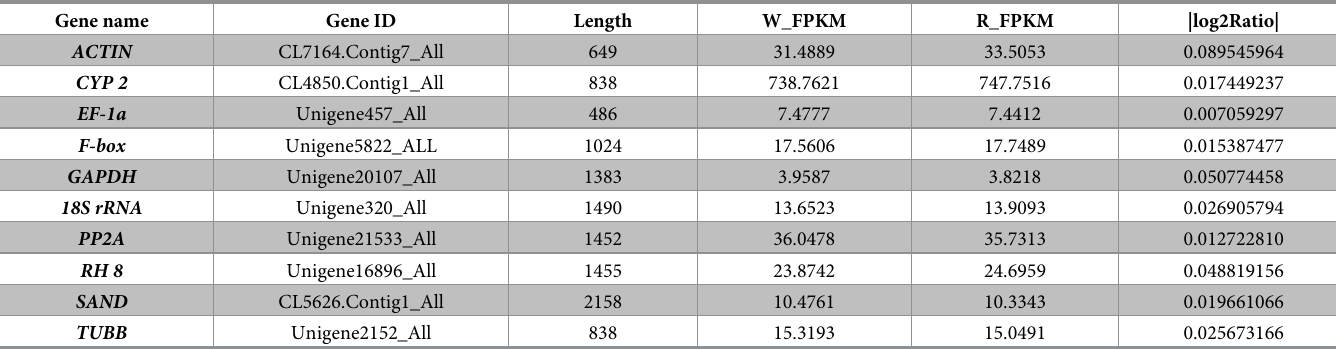
Table 1. The genes for primer design were screened in each candidate gene